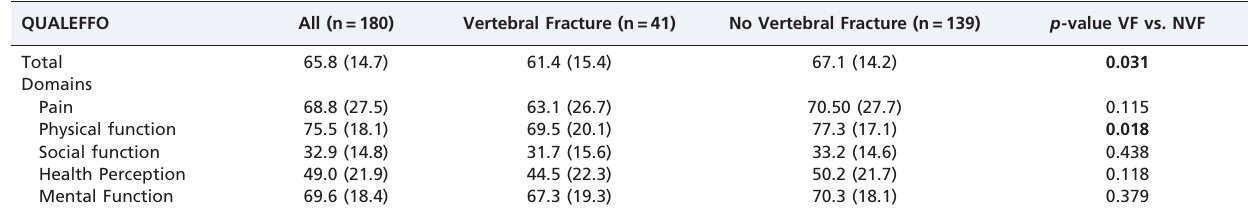
Table 2 - QUALEFFO questionnaire data: total score and score for each domain for the Vertebral Fracture (VF) and No Vertebral Fracture (NVF)